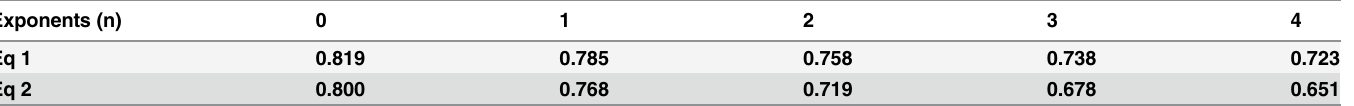
Table 1. Spearman correlation coefficients between the discrepancy functions ( χ ) and RMSD. The correlations are estimated based on 22,5000 decoys generated in the forward MD simulations. The discrepancy function with ten different forms are for q max = 0.6 Å -1 .